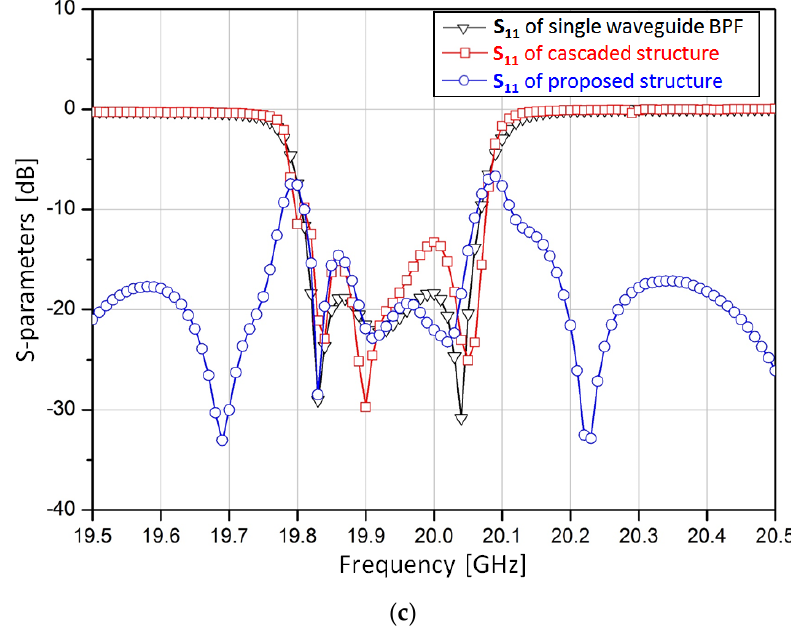
Figure 6. The proposed hybrid ABPF with ( a ) the complete measurement setup, ( b ) the measured transmission characteristics, and ( c ) the measured reflection characteristics compared with the single waveguide BPF (as a reference) and two-stage cascaded BPF.